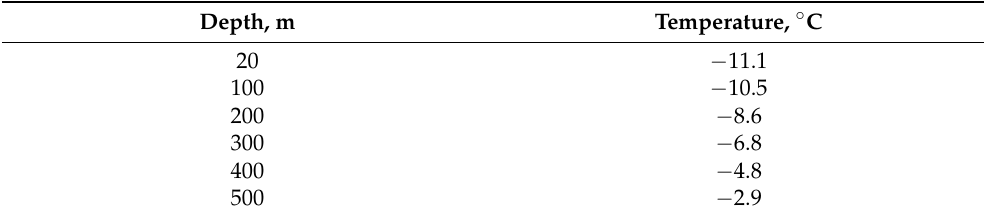
Table 1. Permafrost temperatures in the Tiksi Bay area measured in January–February 1962